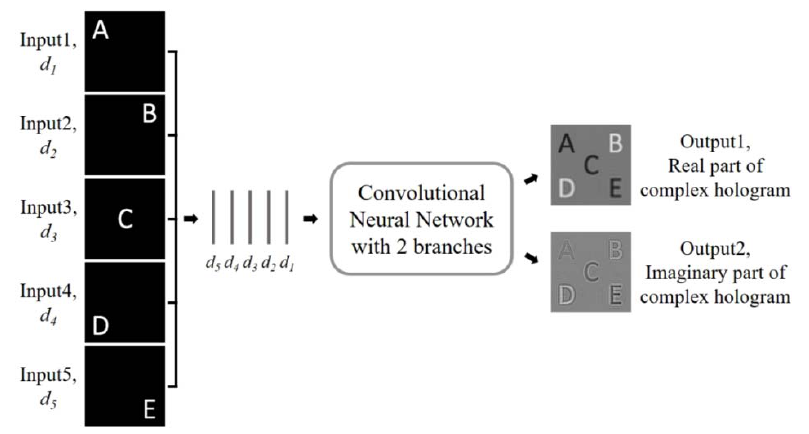
Figure 6. Overall schematic diagram of the MDHGN. Multiple intensity profiles are concatenated in the channel axis and provided as input data. The MDHGN generates a multi − depth complex hologram from the inputs. The real and imaginary parts of the complex hologram are calculated, respectively. (Adapted from [29]).